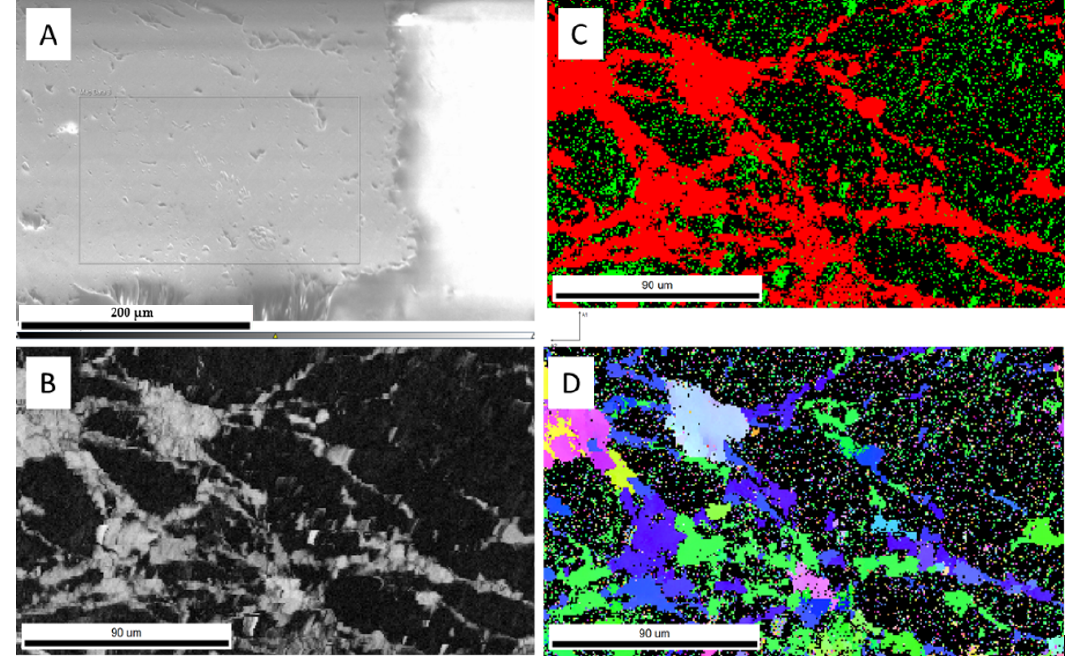
Figure 6. The SEM and EBSD analyses (sample 3 & ) show the lack of crystallinity (dark areas): ( A ) SEM image; ( B ) diffraction intensity map; ( C ) EBSD phase map (calcite is red, aragonite is green); ( D ) EBSD crystallographic orientation map of aragonite and calcite crystals.